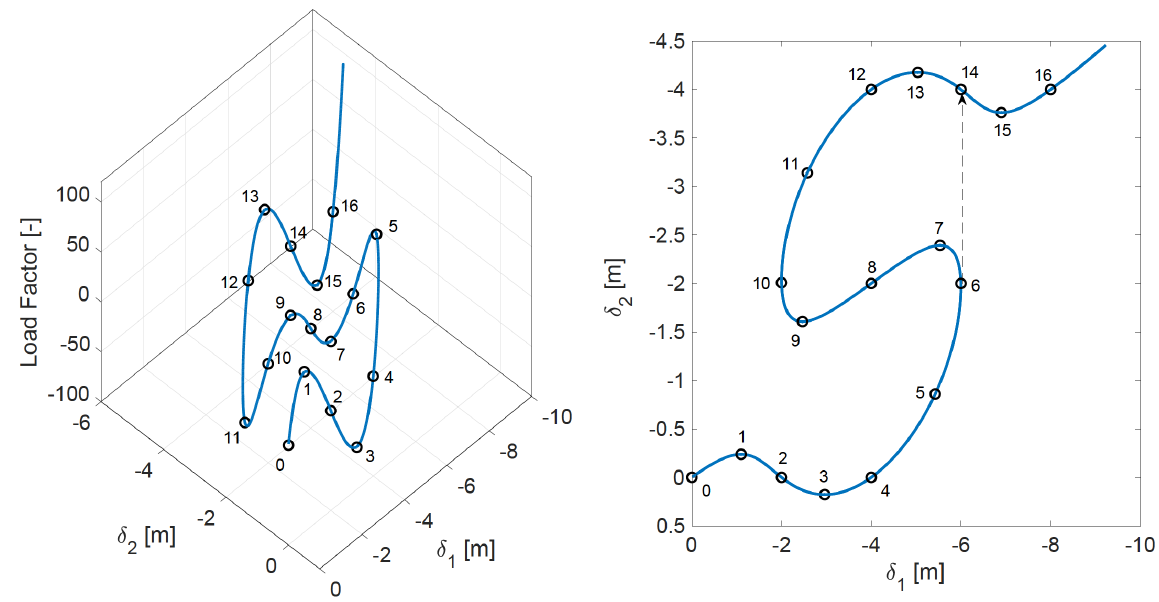
Figure 14: Sixteen-member structure load-displacement curve (Case 1 – λ up = 13.0 ): three-dimensional view (left) and top projection